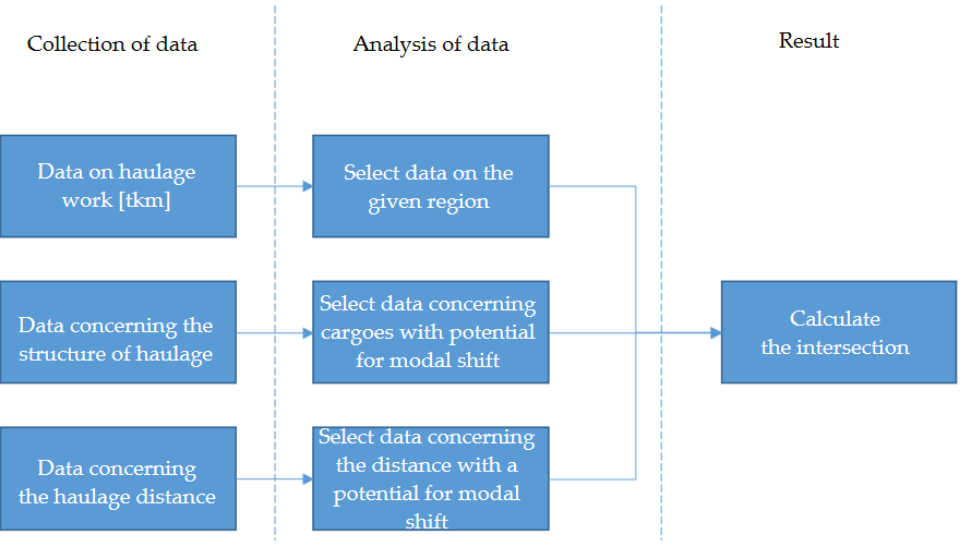
Figure 2. Plan of data preparation for the calculation of modal shift-susceptible